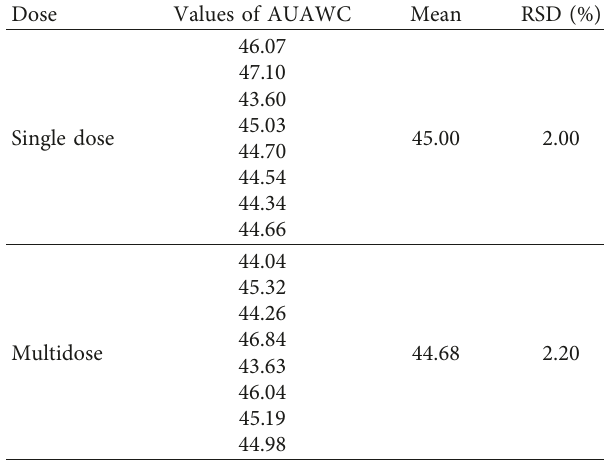
Table 2: The AUAWC values of blank plasma from randomized rats ( n 8). (cid:31)